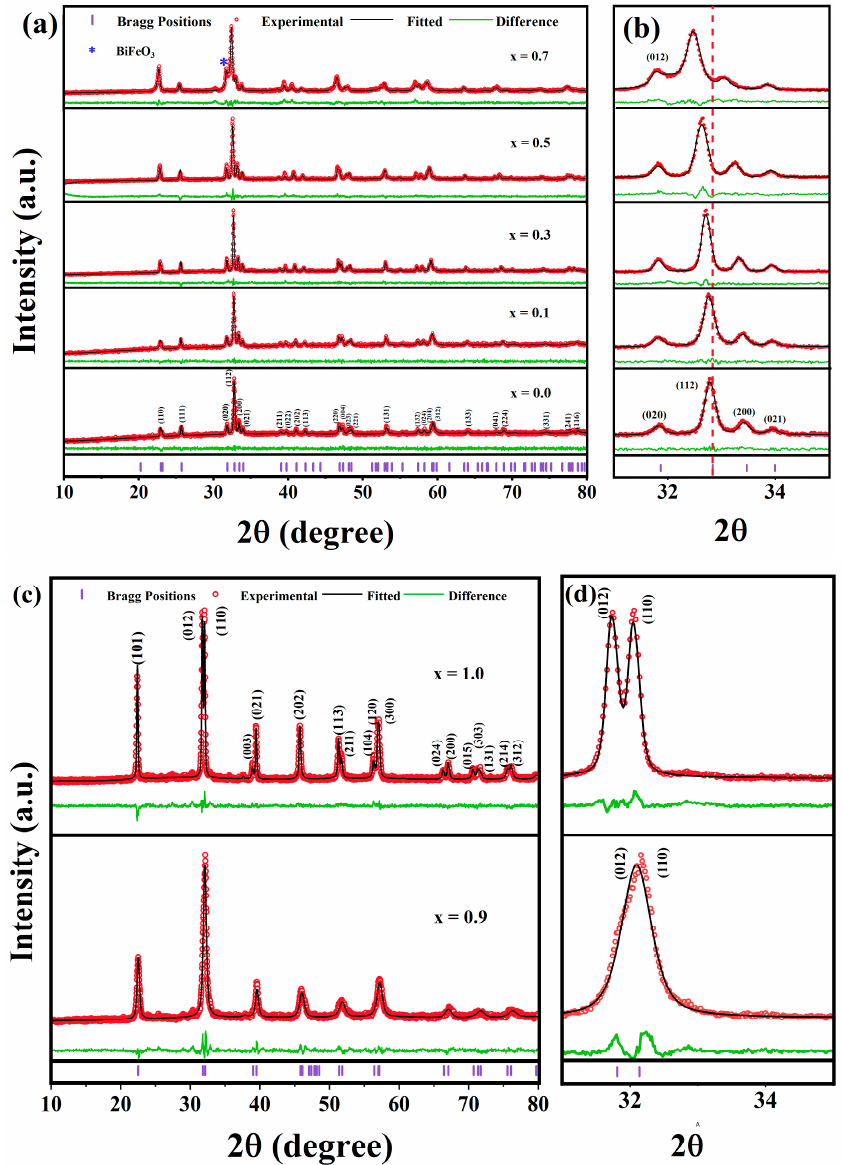
. Figure 1. XRD patterns of ( a ) Gd 1 x Bi x FeO 3 (x = 0, 0.1, 0.3, 0.5, 0.7) annealed at 700 ◦ C; Figure 1. XRD patterns of ( a ) Gd 1 − x Bi x FeO 3 (x = 0, 0.1, 0.3, 0.5, 0.7) annealed at 700 °C; ( c ) Gd 1 − x Bi x FeO 3 − ( c ) Gd 1 x Bi x FeO 3 (x = 0.9, 1.0) annealed at 550 ◦ C; ( b , d ) enlarged view of 2 θ from 31 ◦ to 35 ◦ . (x = 0.9, 1.0) annealed at 550 °C; ( b , d ) enlarged view of 2 θ from 31° to 35°. − Table 1 shows the refined unit cell parameters, bond angle, bond length and goodness Table 1. Refined structural parameters for Gd 1 − x Bi x FeO 3 (x = 0, 0.1, 0.3, 0.5, 0.7, 0.9, 1.0) samples. of fit. For the samples of Gd x Bi 1 x FeO 3 (x = 0, 0.1, 0.3, 0.5), the lattice parameters of the − component-driven structural distortions. For the samples of Gd x Bi 1 x FeO 3 (x = 0.7, 0.9, −